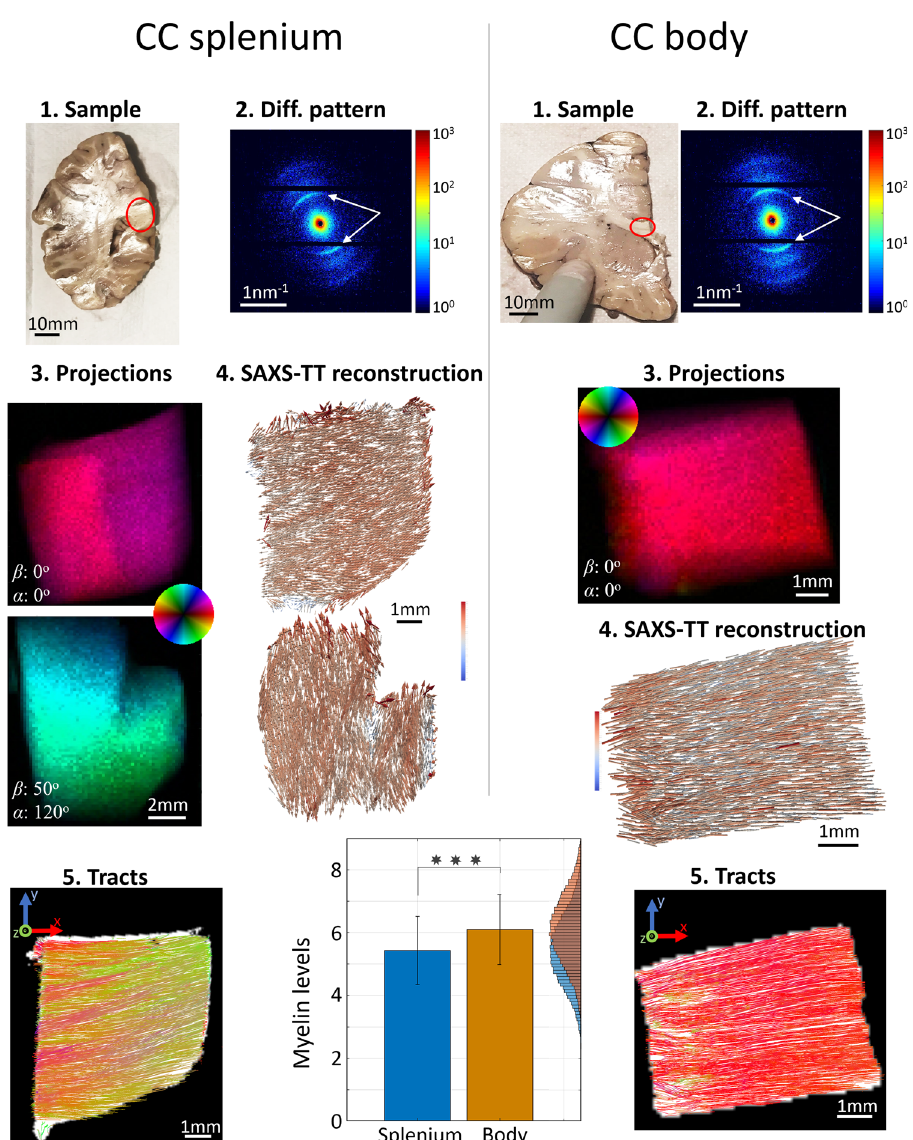
Fig. 4 SAXS-TT on corpus callosum (CC) splenium and body specimens of a 2-year-old female. 1 Samples, in red circle, were raster scanned and 2 produced strong myelin peaks in their diffraction patterns (white arrows). 3 Each 2D scan resulted in a projection depicting SAXS myelin peak intensity and 2D orientation of the myelinated axons. 4 Tensor-tomographic reconstruction of all projections provided 3D fi ber orientations per voxel, here visualized by vector maps for virtual sections. Vectors are colored based on myelin levels in the corresponding voxel. 5 Tractography algorithms enabled generating neuronal tracts for the two specimens, representative sections of which are shown here. The bar graph at the bottom of the fi gure shows the myelin levels — and respective standard deviations — of the specimens, with the body displaying signi fi cantly higher values. Histogram of the values with the same colors is shown to the right of the fi gure. Signi fi cance p values of the unpaired two-tailed t -test and the two-sample Kolmogorov – Smirnov test is 0. Splenium contained n = 70,007 voxels, and body n = 51,096 voxels. Source data are provided as a Source Data fi